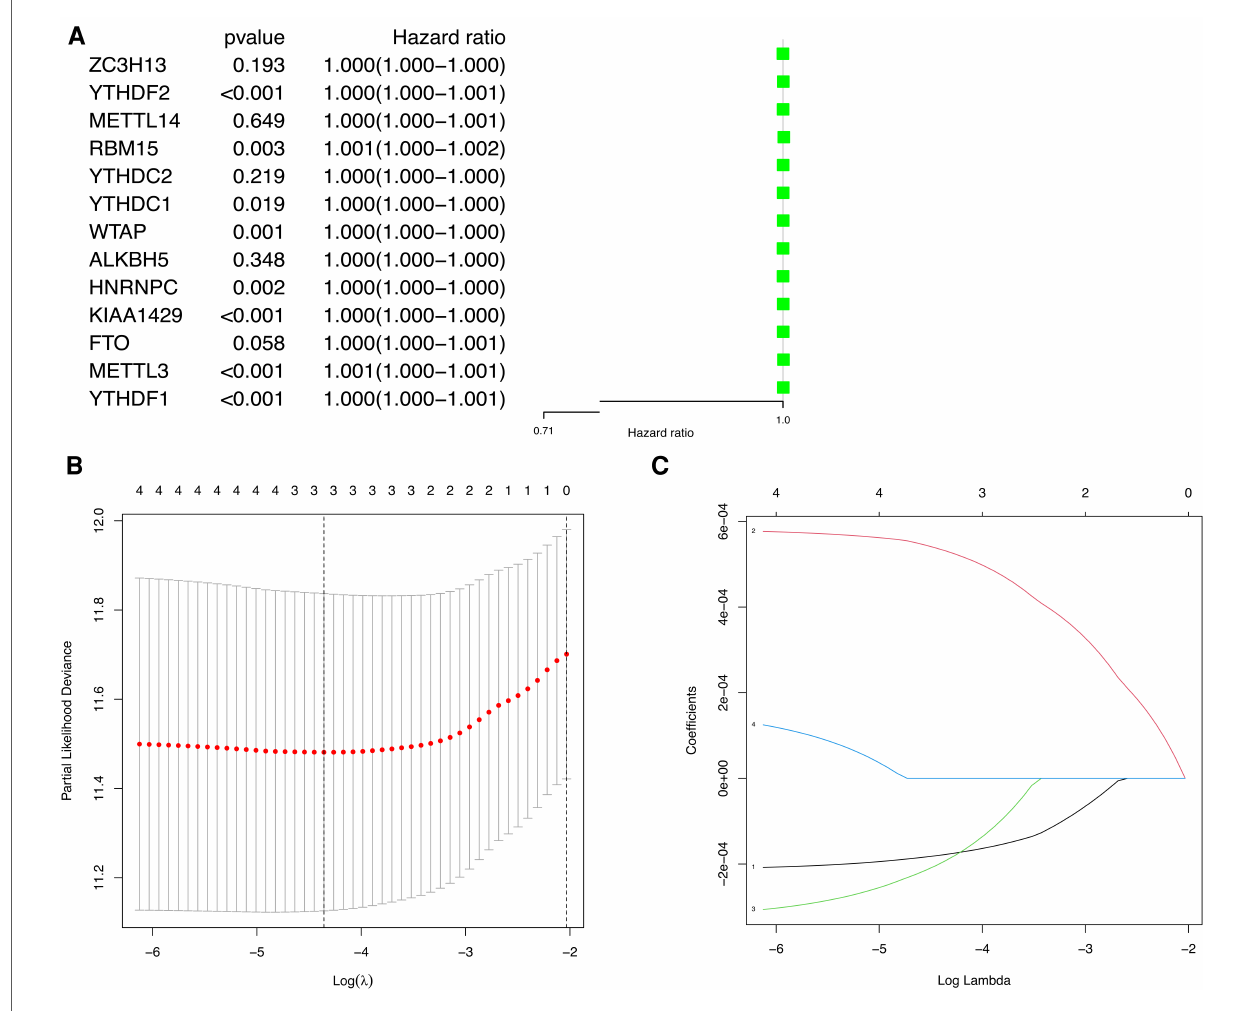
FIGURE 4 The univariate Cox regression analysis and LASSO regression analysis applied to screening m6A methylation-related genes that optimal used for the construction of the prognostic model. ( A ) The signi fi cantly related to survival m6A methylation-related gene by univariate Cox regression analysis. ( B ) Screening of optimal parameter (lambda) at which the vertical lines were drawn. ( C ) LASSO coef fi cient pro fi les of the fi ve m6A methylation-related genes with non-zero coef fi cients determined by the optimal